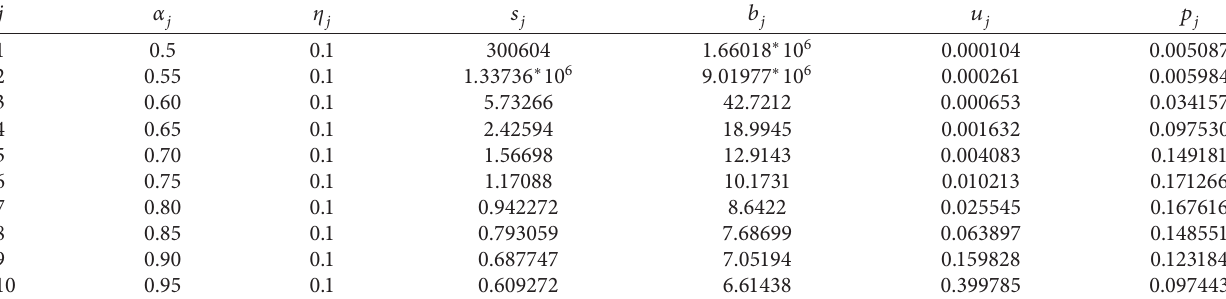
Table 1: Prior information, hyperparameters, and posterior probabilities.